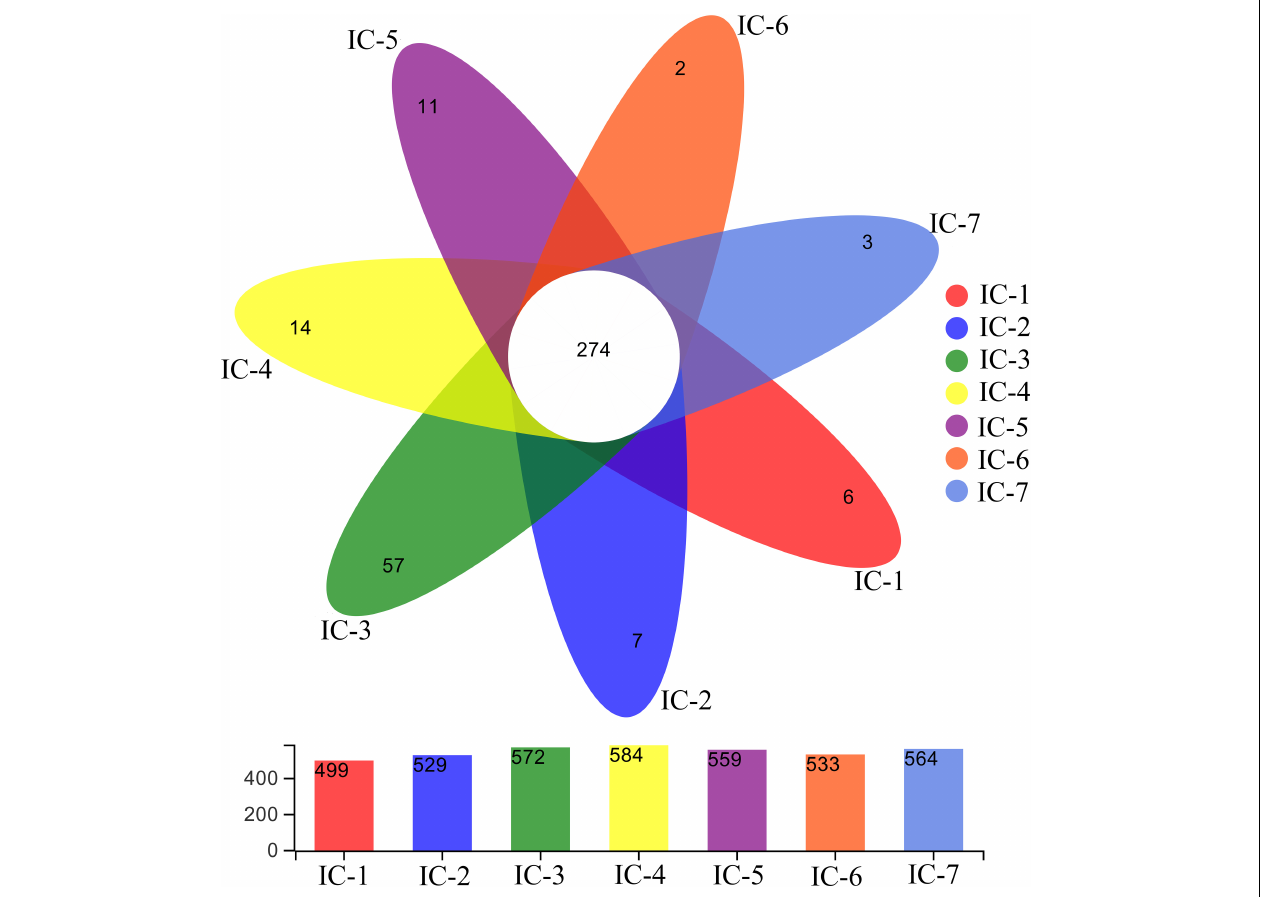
FIGURE 3 | Venn diagram of samples from UASB reactor. The numbers represent OTUs at 97% similarity. IC-1, IC-2, IC-3, IC-4, IC-5, IC-6, and IC-7 represent the granular samples at OLRs of 1.43, 2.86, 4.29, 5.72, 7.15, 8.58, and 10.01 g COD/L ·